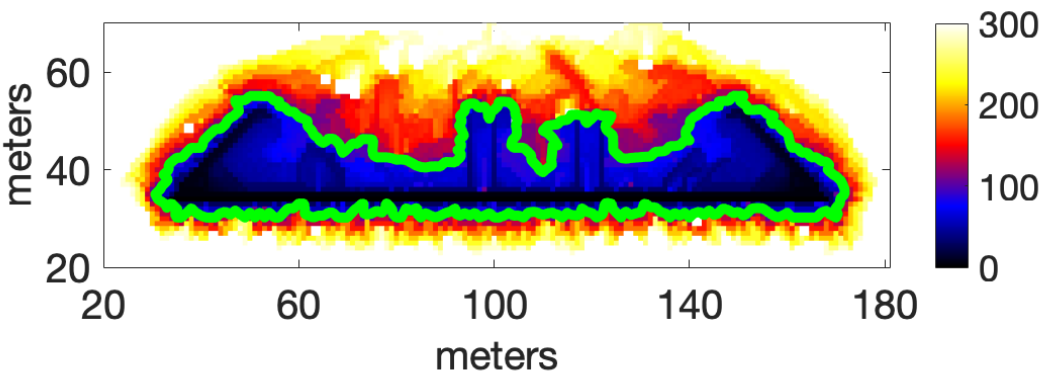
Figure 11. The first arrival time, in seconds, of a head fire. The background wind is U BG = 4 m/s, the sink velocity is U sink = 7.27 × 10 − 2 , the vortical velocity is U vort = 4.54 × 10 − 1 , and the burn time is τ b = 25 s. The negative vorticity results in dynamic fingers that then turn into separate head fires. The green curve is the fire line at t = 100